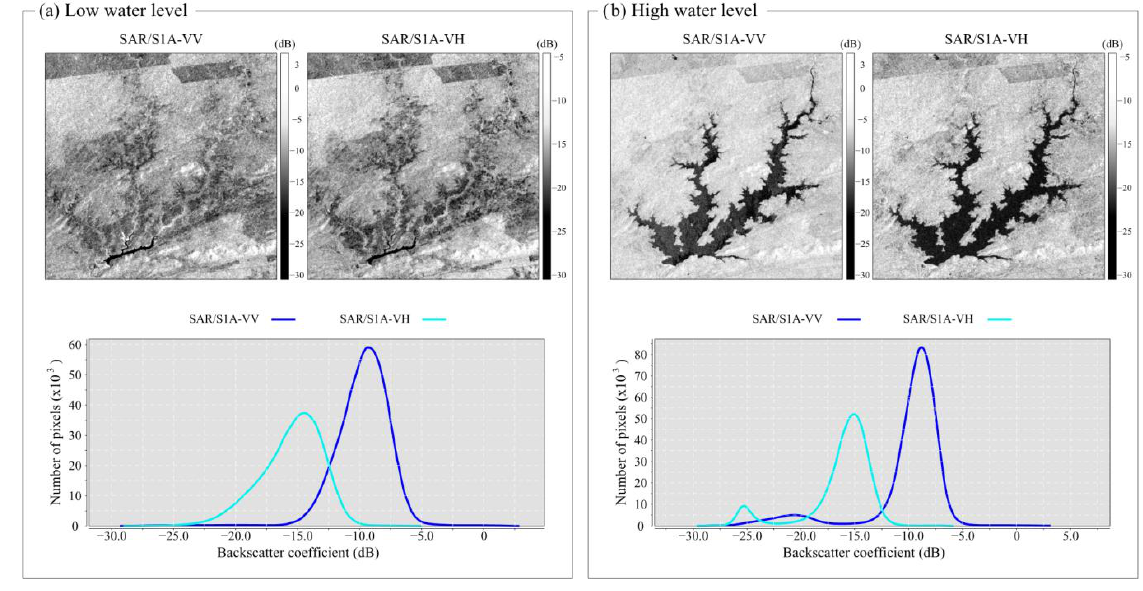
Figure 9. Sentinel-1A images: ( a ) low water level (16 February 2018) and ( b ) high water level (29 June2020).